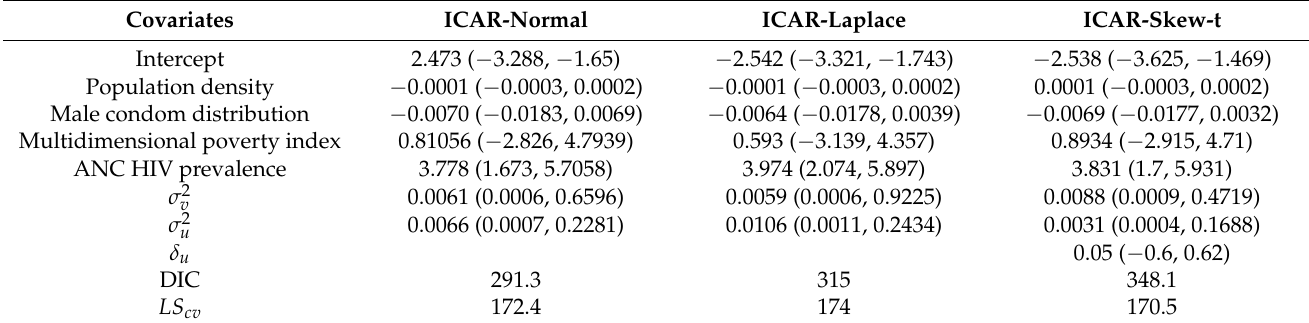
Table 1. Comparison of the fitted models using DIC and